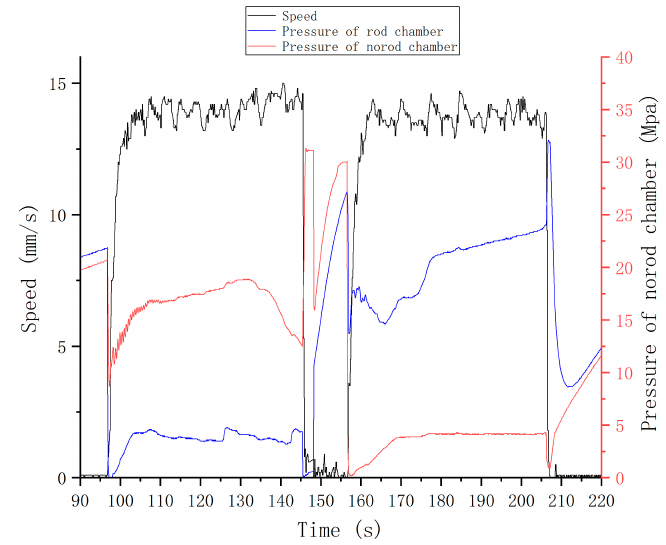
Figure 30. Step response experiment results of cylinder #6 using PID.